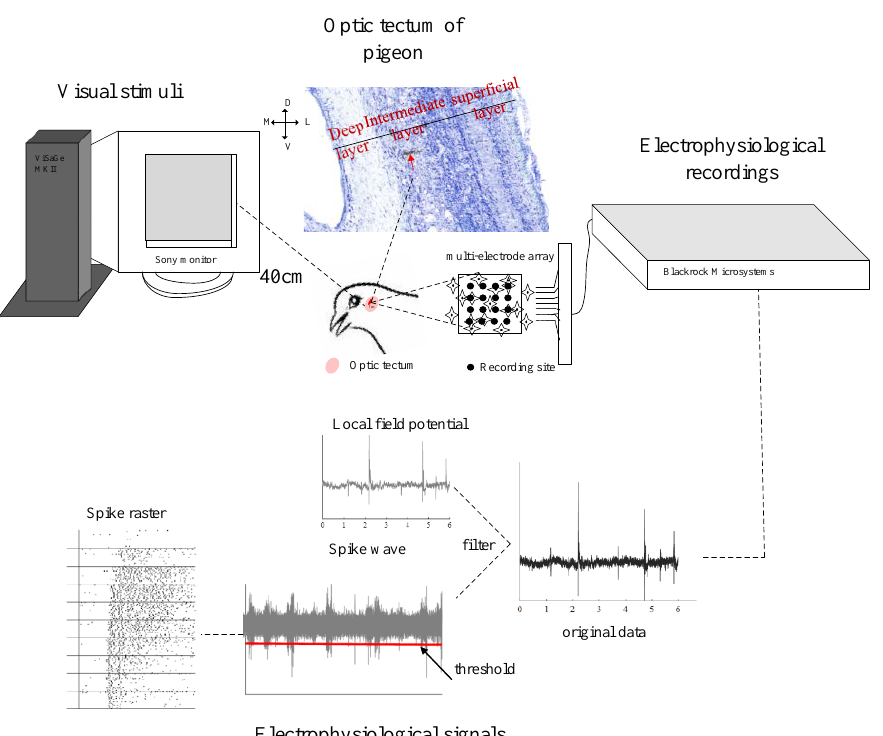
Figure 1. Schematic illustration of the experiment. Pigeons were anesthetized and restrained in a stereotaxic apparatus. Visual stimuli were generated with the ViSaGe MKII visual stimulus gener- ator and displayed on a cathode ray tube monitor positioned 40 cm in front of each pigeon’s right eye. The neuronal signals were synchronously collected with a cerebus system. The spikes were detected by thresholding the band-pass filtered (Second-order Butterworth) raw signals between 250 and 5 kHz with a sampling rate of 30 kHz. The lower left presents an example of spike trains of 20 repeats under different stimuli. The vertical line indicates the onset of each stimulus and the horizontal line separates different stimuli. Each black dot represents a spike.